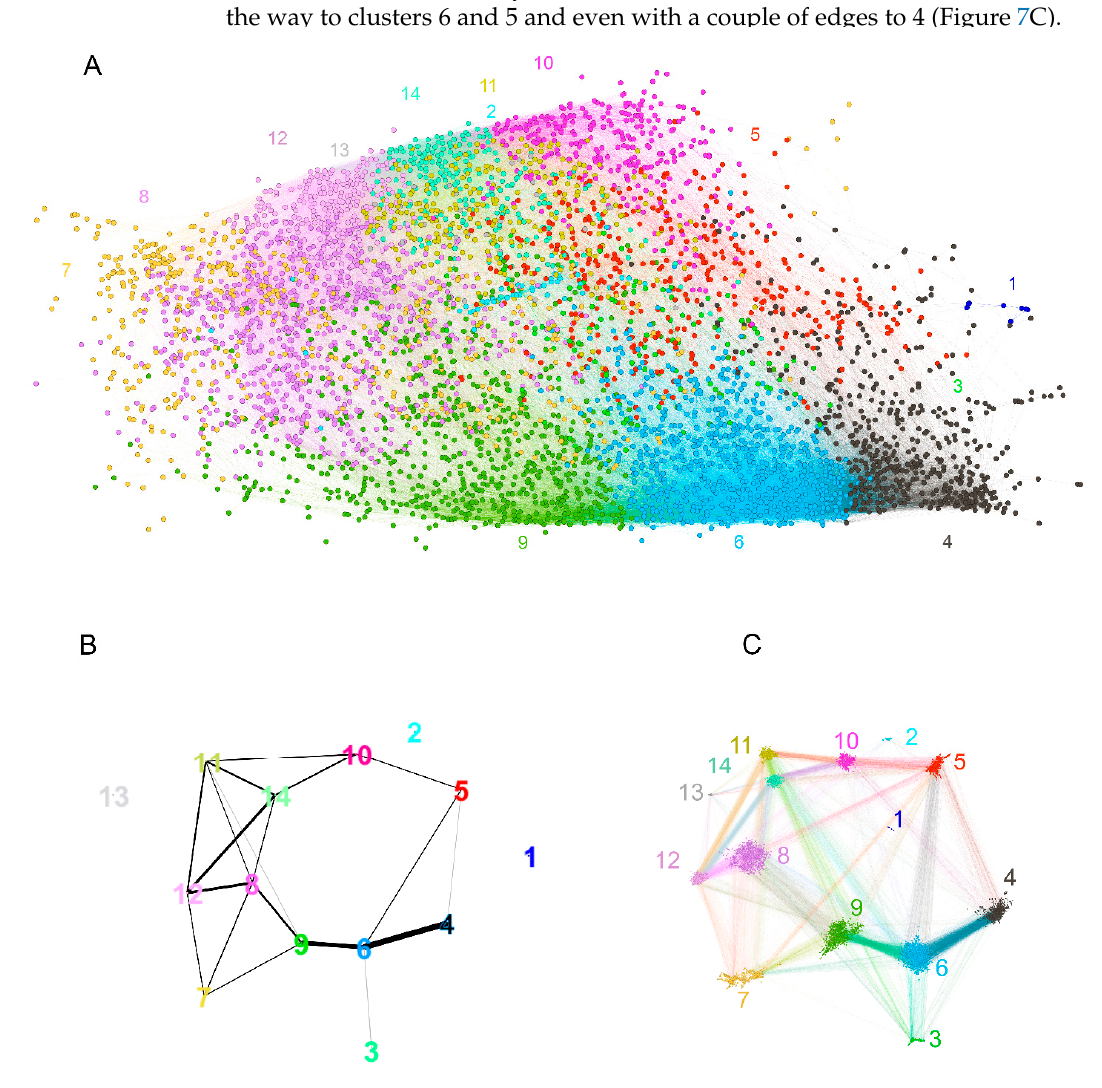
Figure 7. Reactivity graph topology. ( A ) Color-coded labeling of the clusters defined by recursive Louvain clustering. The numbers indicate the number of the cluster and are of the cluster’s color. ( B ) Graph of the clusters with edges based on thresholded modularity of the two adjacent clusters (the modularity was calculated on the induced subgraph containing only the two clusters considered). The colors of the clusters are the same as in ( A ). The threshold used for the plot was selected to illustrate the dominant persistent homology (cycle 5, 6, 9, 8, 14, 10). This proves that the graph has relatively sparse connectivity in the region between those clusters, which is impossible to visualize in the 2D layout ( A ) because they are overlayed. ( C ) Rearrangement of the graph to show the respective topology preserving all edges. The numbers are the numbers of the clusters, and the color code is the same as that in ( A , B ).